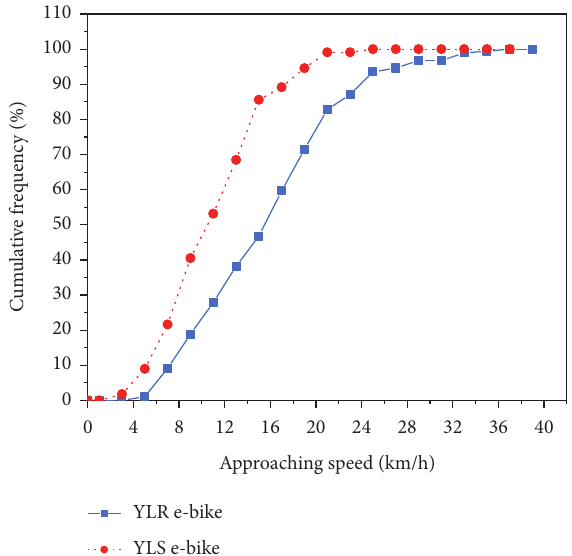
Figure 6: Cumulative frequency curve of approaching speed for YLR and YLS e-bike.